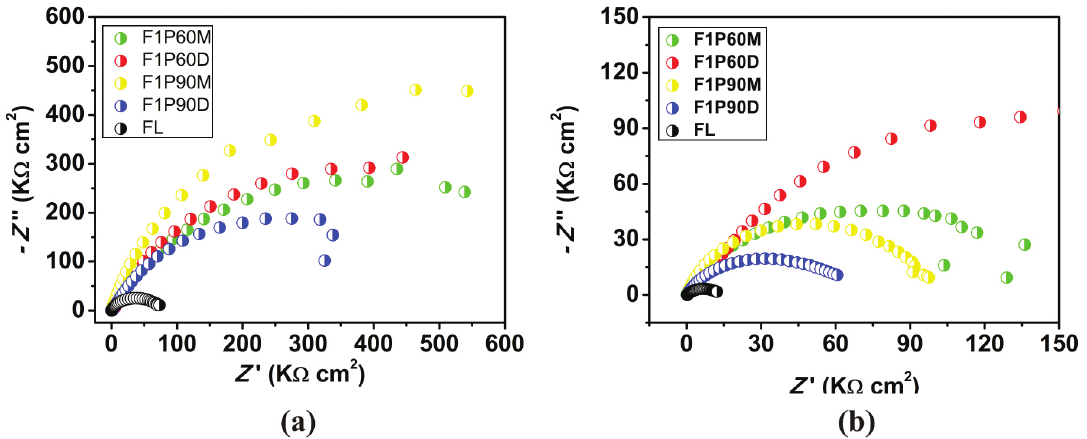
Figure 6. Nyquist plots obtained for hybrid film coated and uncoated tinplate in 0.05 M NaCl solution: (a) 24 and (b) 96 hours of